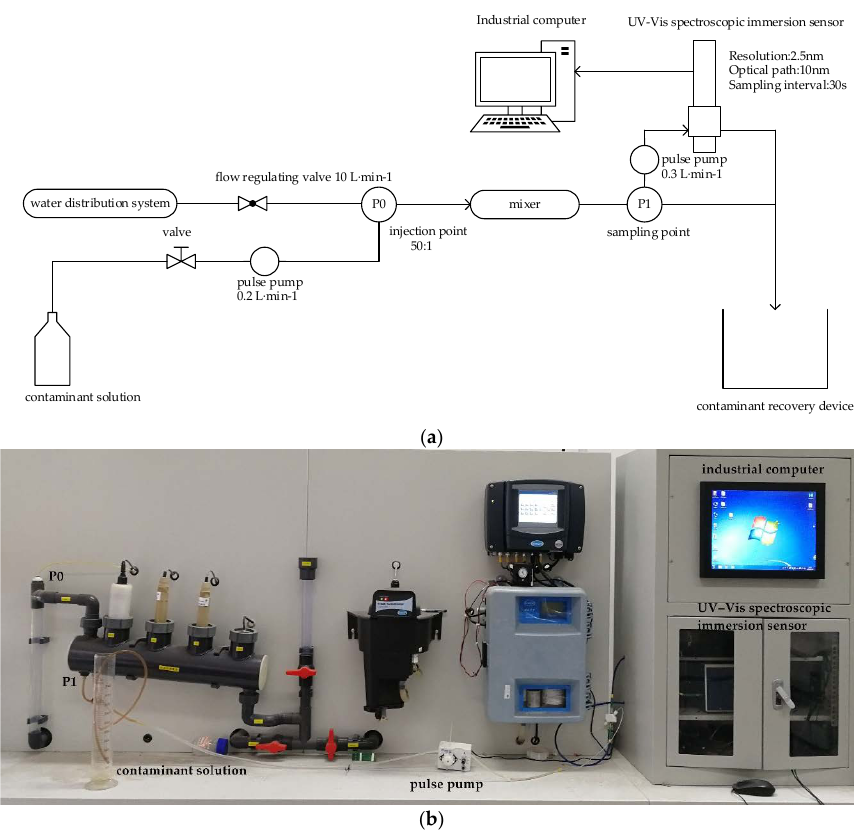
Figure 2. Detection device structure for an urban drinking-water pipe network. ( a ) Schematic Diagram; ( b ) Actual Experimental Installation Diagram.